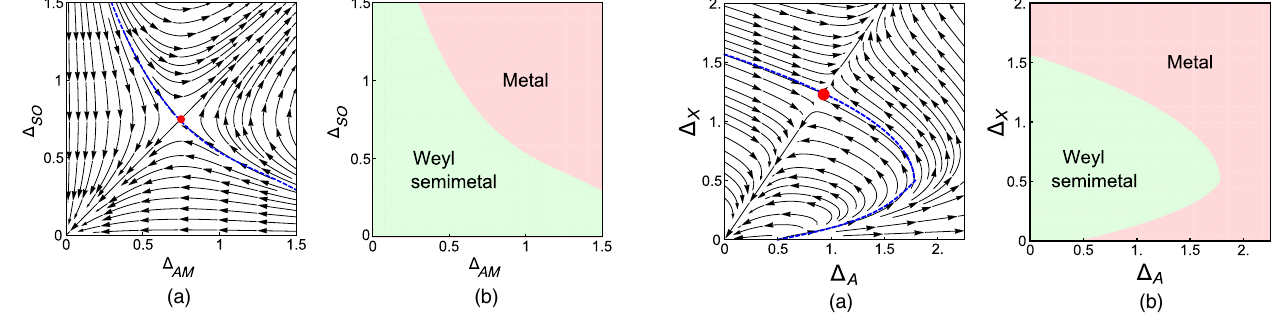
FIG. 16. (a) The renormalization-group flow diagram and (b) corresponding phase diagram in the Δ obtained from ϵ quantum-critical point at Δ phase boundary between the Weyl semimetal and metal in (b) is determined by the irrelevant direction, shown by blue dotted line in (a).